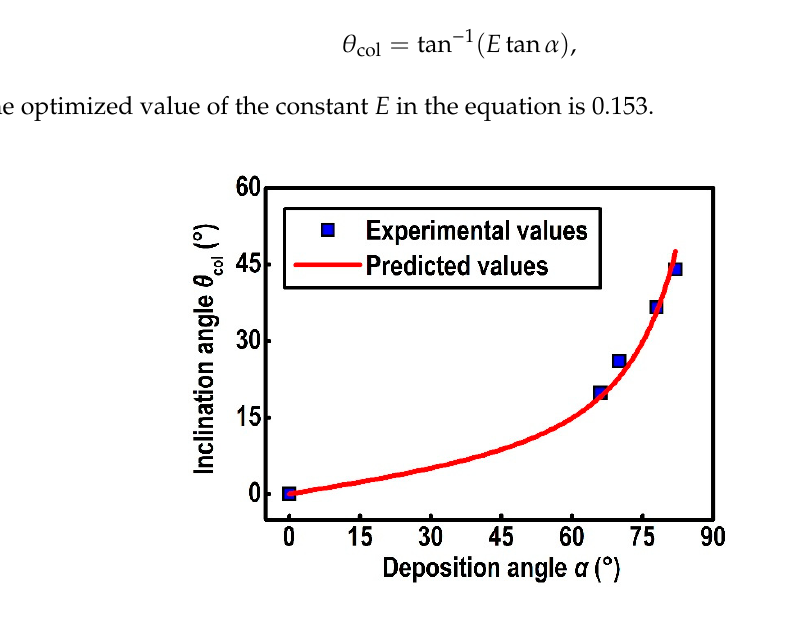
Figure 7. The inclination angle for YF 3 CTFs versus the deposition angle. The filled squares indicate the experimental values, and the solid curve indicates the predicted values by the modified tangent-rule equation.